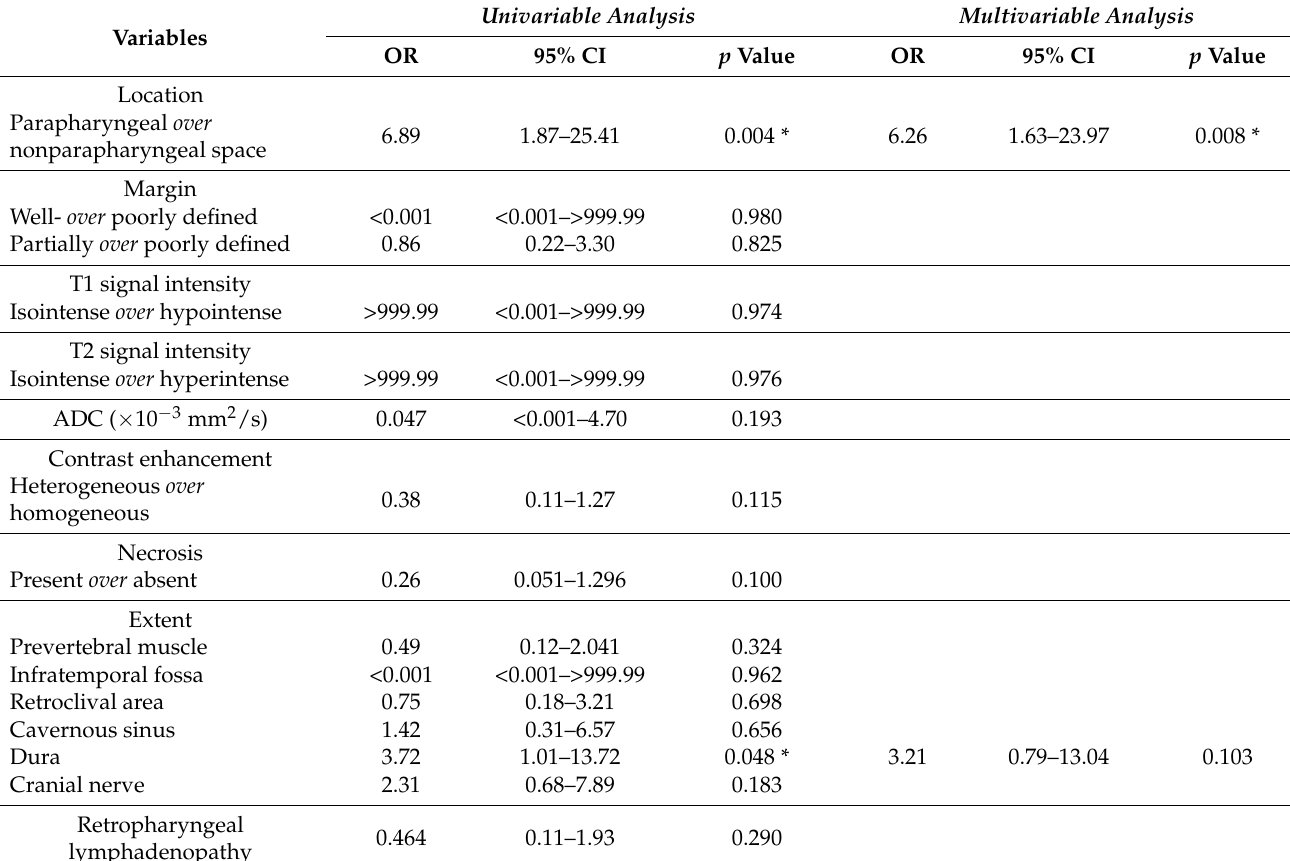
Table 6. Univariable and multivariable analyses for differentiating GPA from